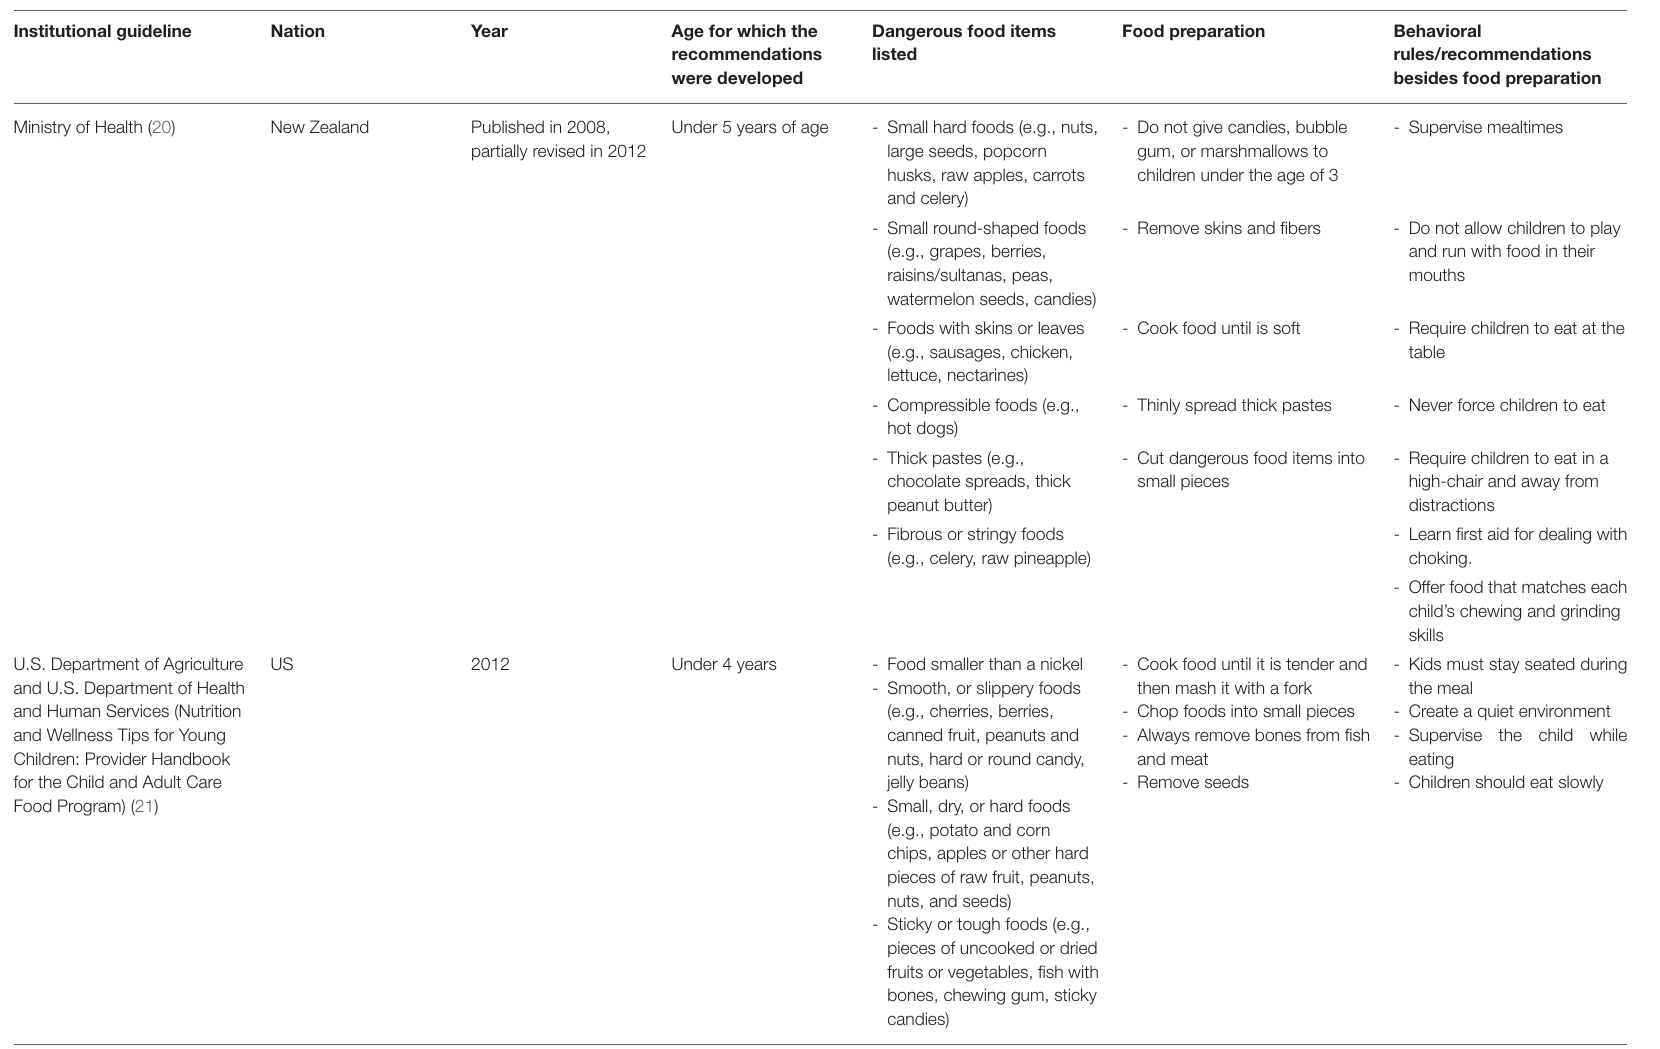
TABLE 1 | Summary of the guidelines retrieved. Institutional